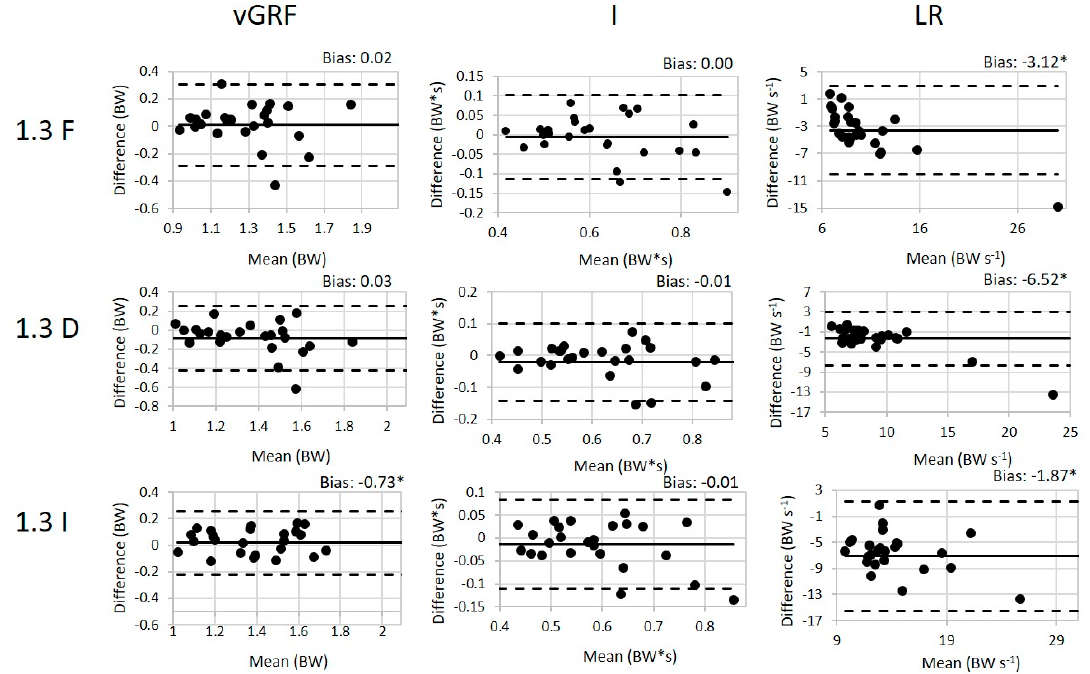
Figure 4. The Bland–Altman plots for each variable during walking conditions (1.3 m/s, flat (F), inclined (I), and declined (D)) with the 100 Hz loadsol ® . The difference is calculated by subtracting the loadsol ® values from the force plate values. The bias (mean difference) is displayed for each variable with a * indicating a statistically significant difference between the force plate and loadsol ® .